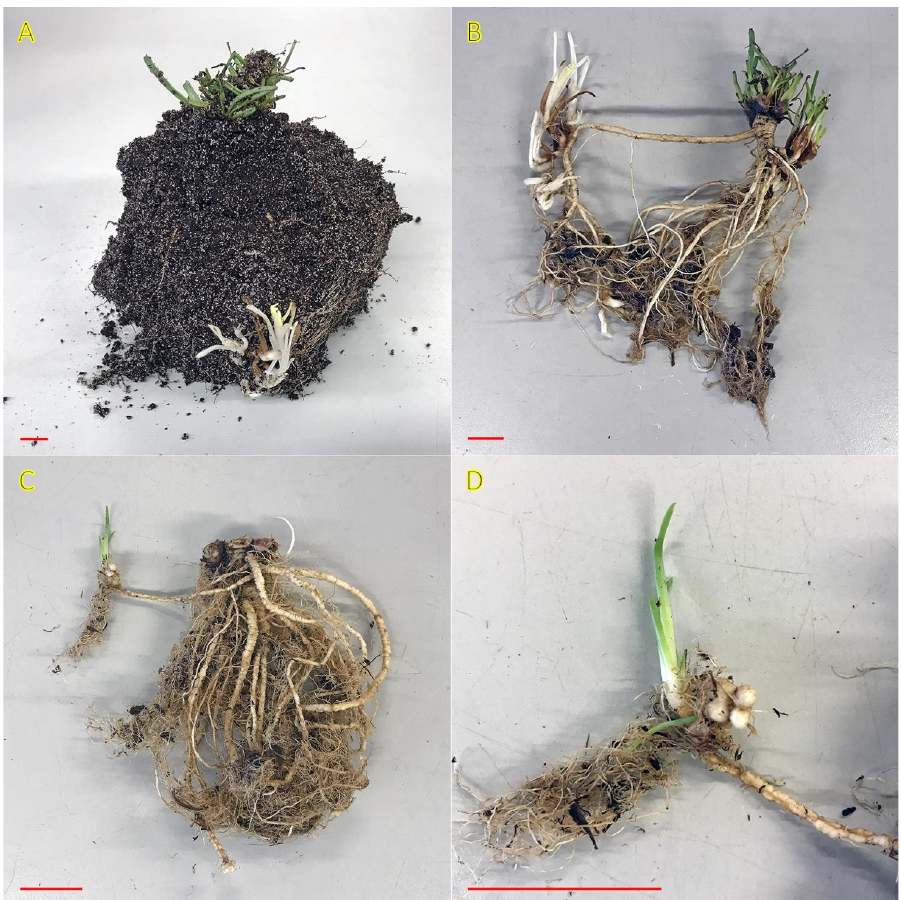
Figure 24. Presence of shoots and tuber-like structures on roots of Plantago maritima plants cultivated in controlled conditions in presence of 5 g L −1 Na + in a form of chloride. ( A ), defoliated individual taken out from a container together with a substrate with an etiolated shoot at the lower corner of the container. ( B ), the same plant as in ( A ), with the substrate removed. ( C ), defoliated plant with the substrate removed showing shoot emerged aboveground. ( D ), the same shoot as in ( C ) with tuber-like structures. Bar indicates 10 mm.